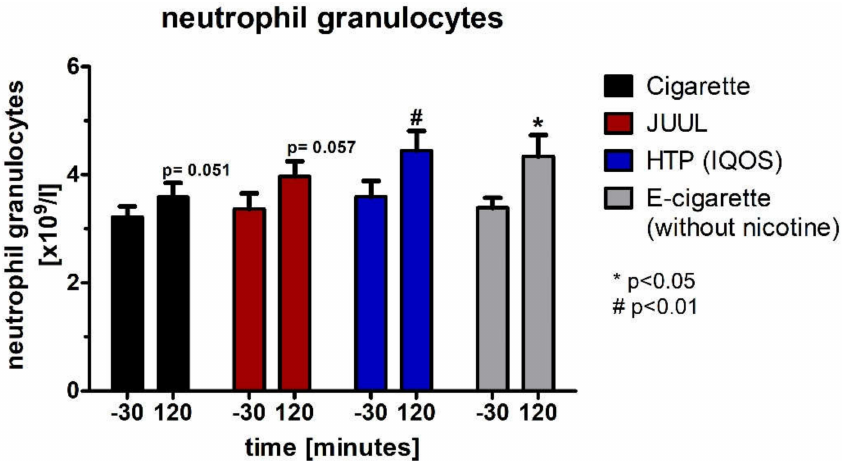
Figure 13. Neutrophil granulocytes analyzed before as well as 120 min after consuming the cigarette, JUUL TM , heated tobacco product, and e-cigarette without